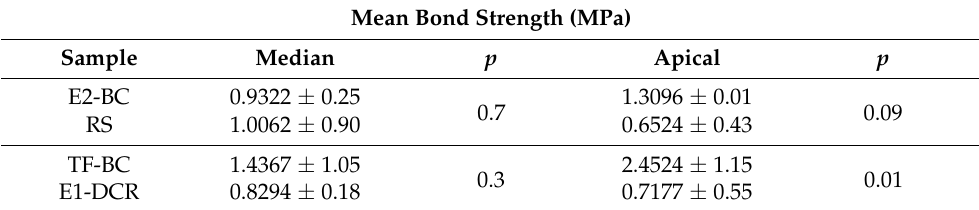
Table 3. Mean bond strength of the four